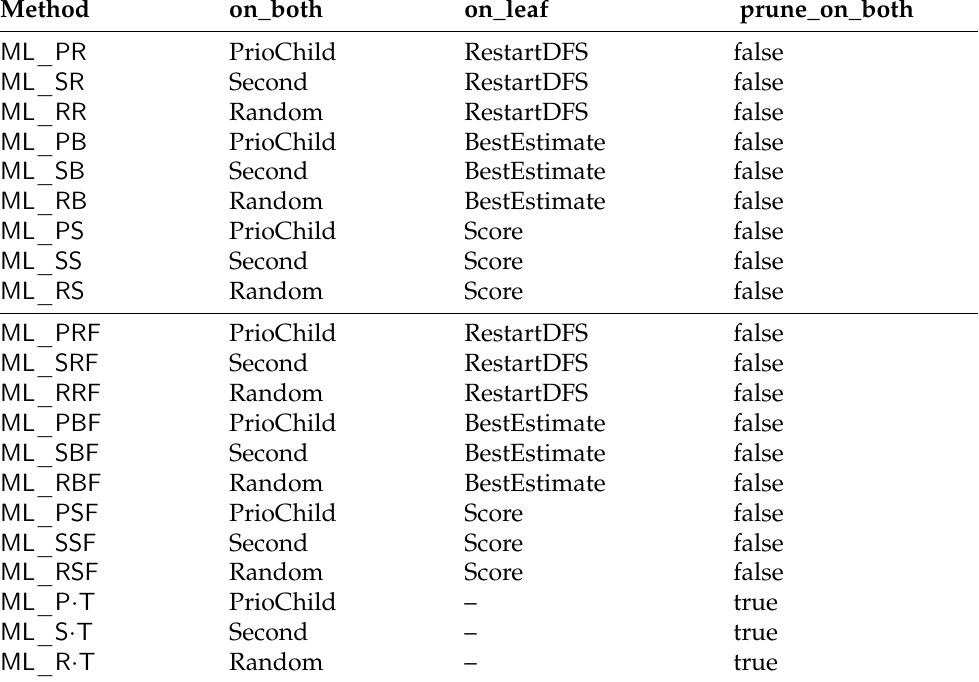
Table 4. The node selection (top) and pruning (bottom) policy configurations in full.